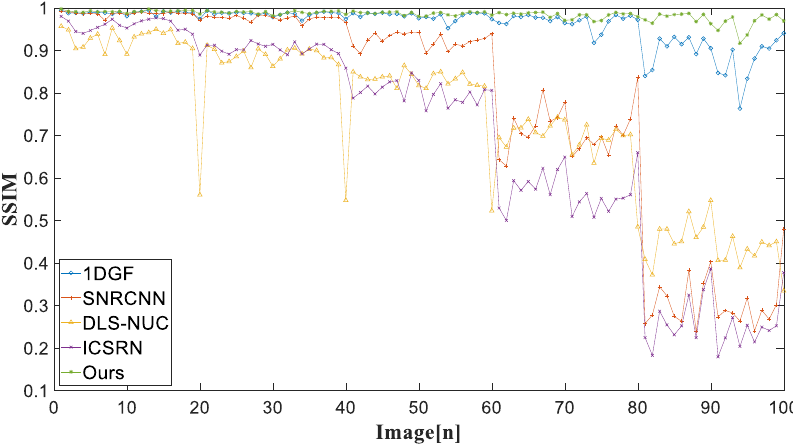
Figure 10. SSIM of different methods for 100 simulated noise infrared images.